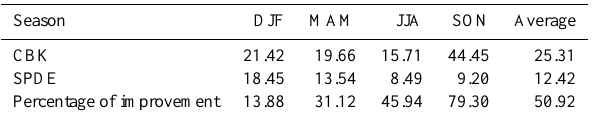
Table 6. Comparison with satellite data over all seasons and aver- aged over 2000–2005 RMSEs for covariance-based kriging (CBK) and SPDE predictions.